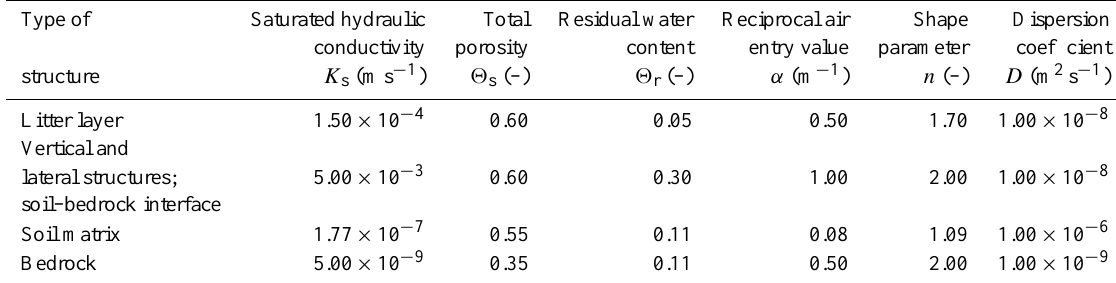
Table 2. Hydraulic and transport parameter values used for different materials in the basic model